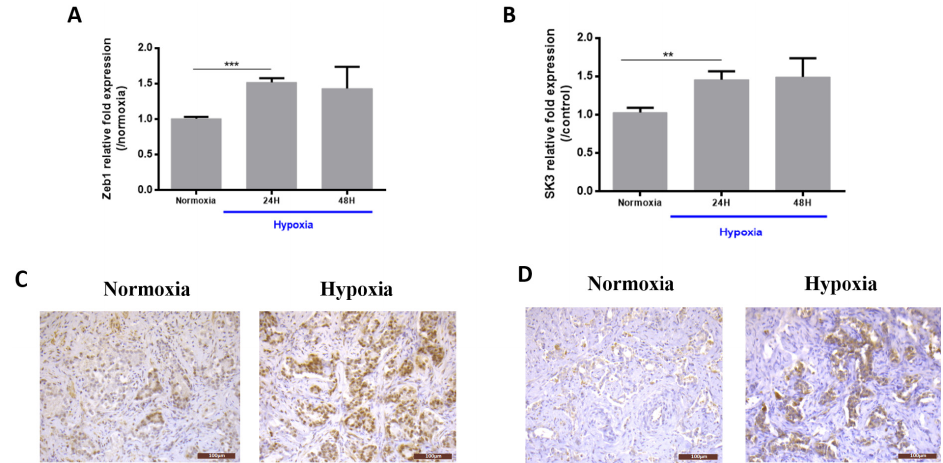
Figure 1. Expression of Zeb1 and SK3 channel under hypoxia conditions. ( A ) Zeb1 and ( B ) SK3 expression in PC3 cells. Cells were cultured under normoxic conditions for 24 h and then were cultured